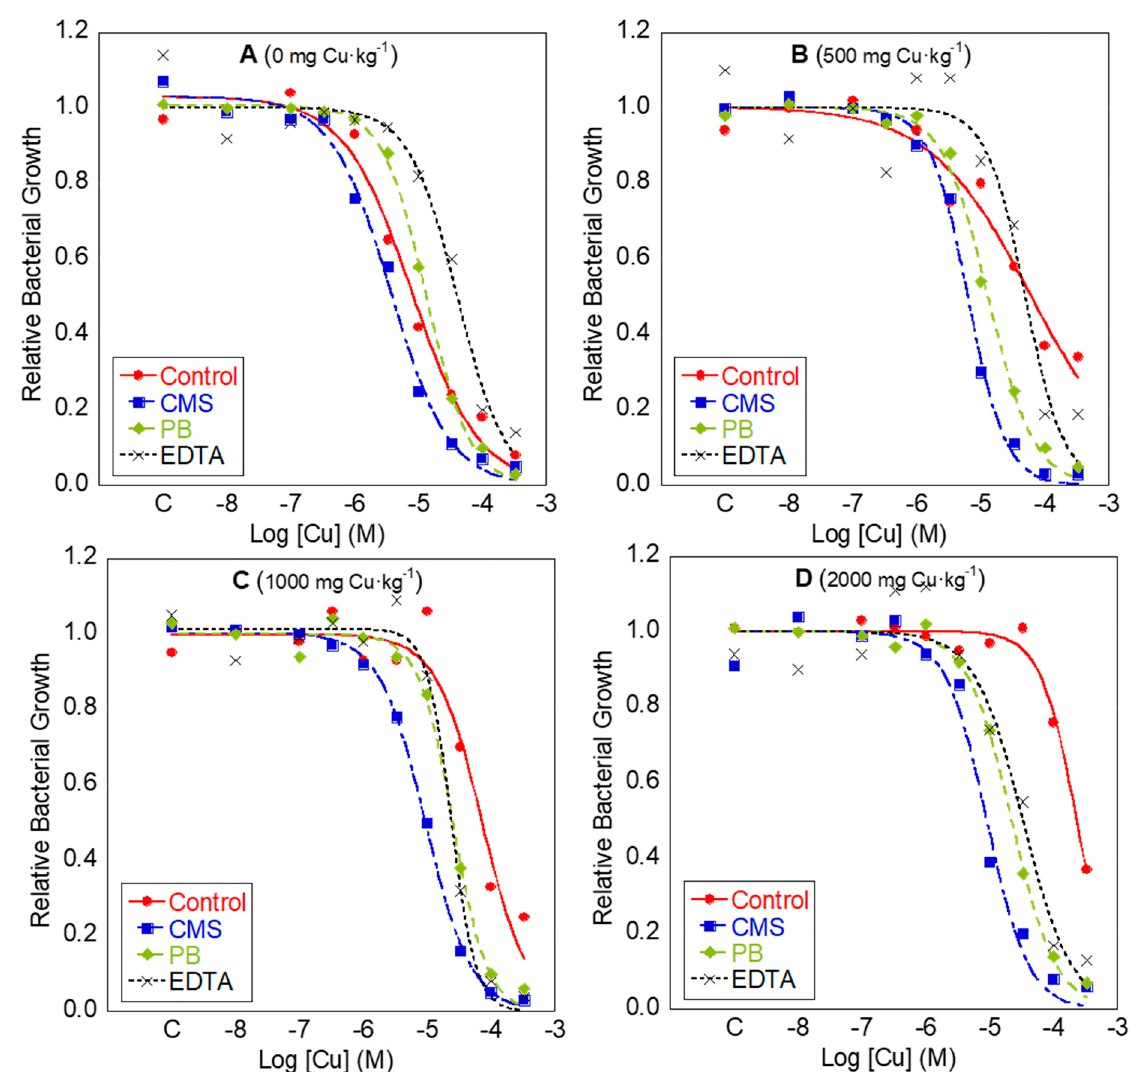
Figure 1. Dose–response curves of relative bacterial growth versus added Cu to bacterial suspensions from a polluted soil with four Cu levels: 0 ( A ), 500 ( B ), 1000 ( C ), and 2000 ( D ) mg Cu·kg − 1 . Each Cu level was remediated with four treatments: crushed mussel shell amendment (CMS, blue dots and line), pine bark amendment (PB, green dots and line), EDTA washing (black dots and line), and control (red dots and line).